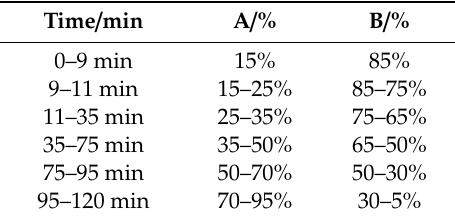
Table 4. The time program of gradient